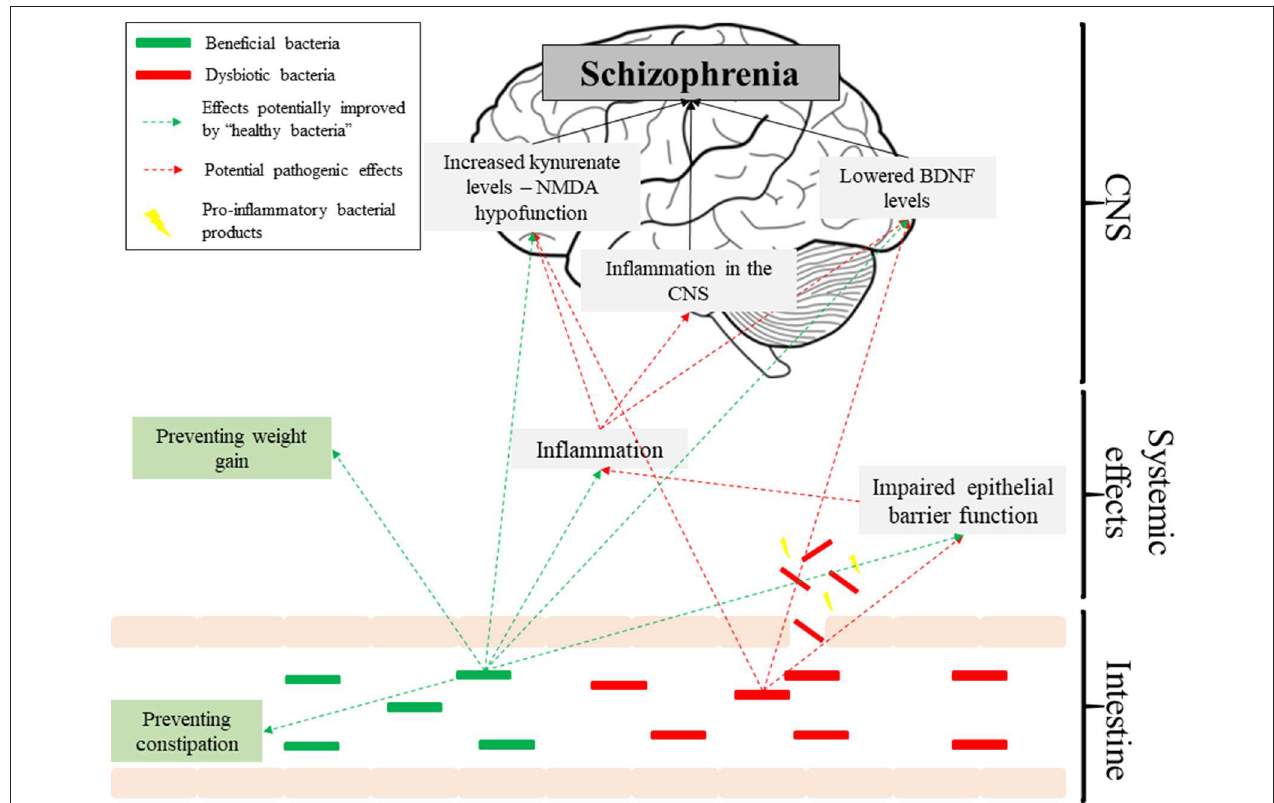
FIGURE 1 | Pathways potentially affected by the microbiome in